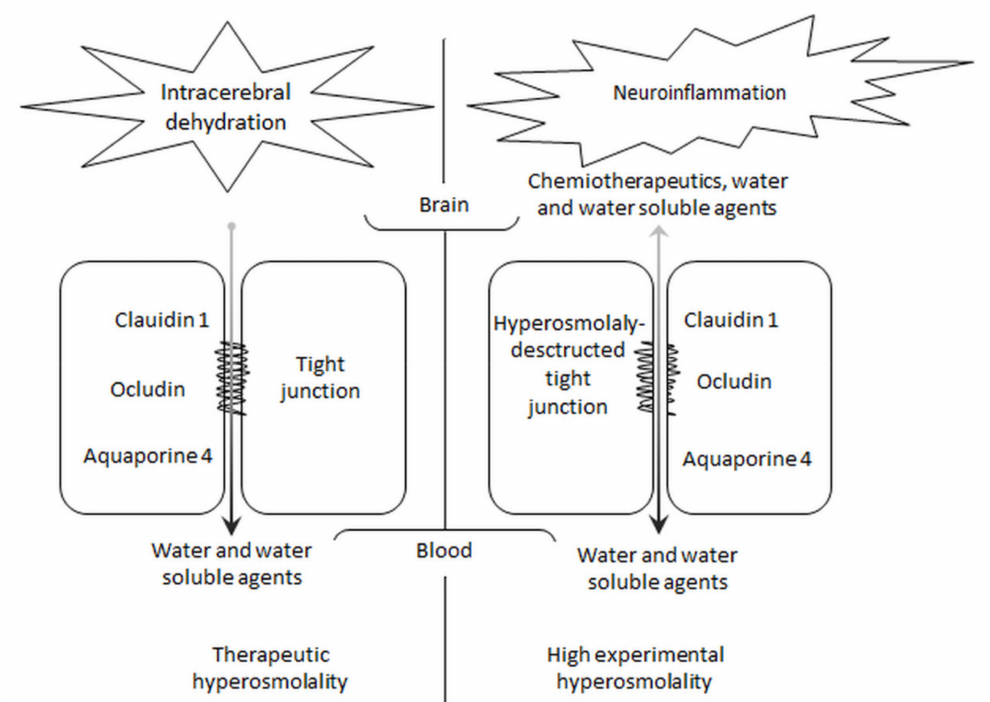
Figure 4. General scheme showing the effect of hyperosmolality on the blood–brain barrier. Thera- peutic increase in plasma osmolality intense water removal from the brain. Experimentally raised osmolality to the high value disrupts the blood–brain barrier from opening the tight junction for intracerebral shifts of chemotherapeutics, water, and other water-soluble and insoluble